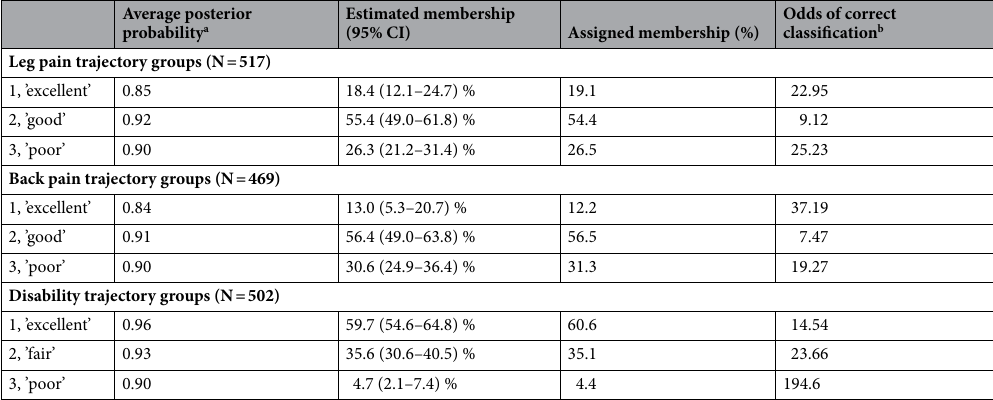
Table 2. Assignment to trajectory groups based on outcomes of leg pain, back pain, and disability. a Minimum threshold = 0.70. b Minimum threshold = 5.0.